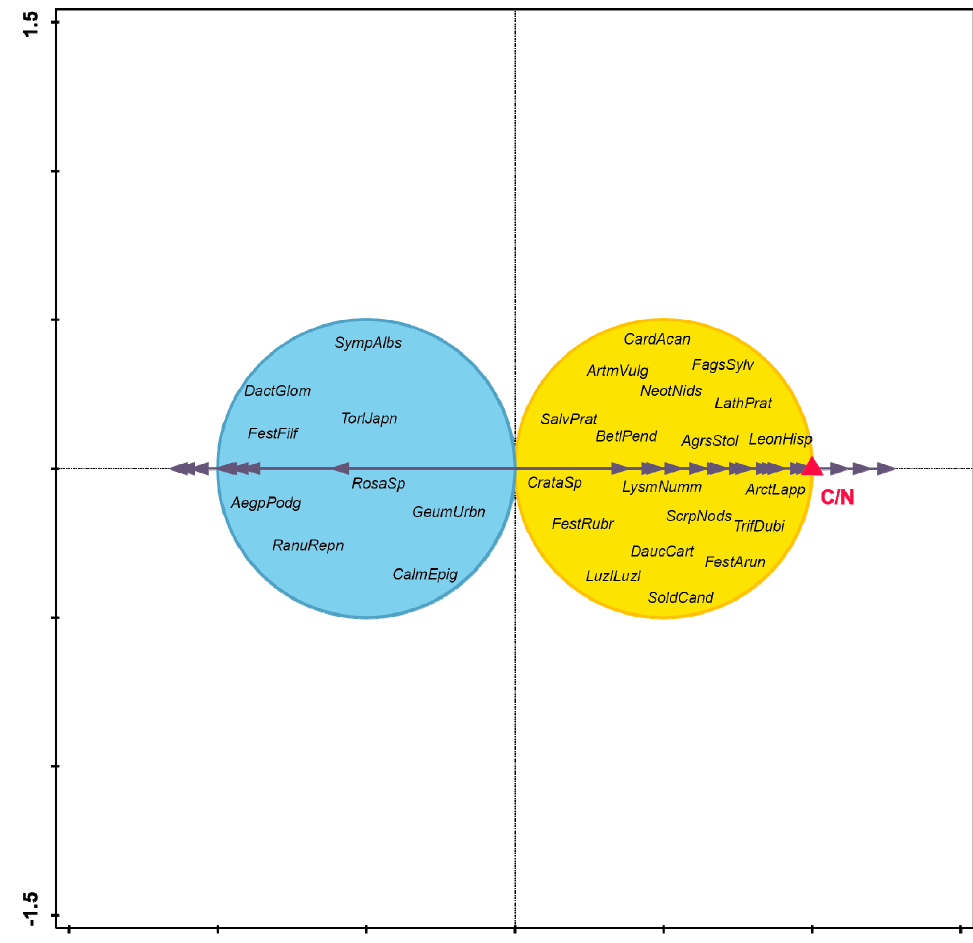
Figure 7. Van Dobben circles on the bases of CCA, the blue circle shows species negative responses, and the yellow ring shows the positive reactions of species on the C/N ratio (red triangle). Aegopo-